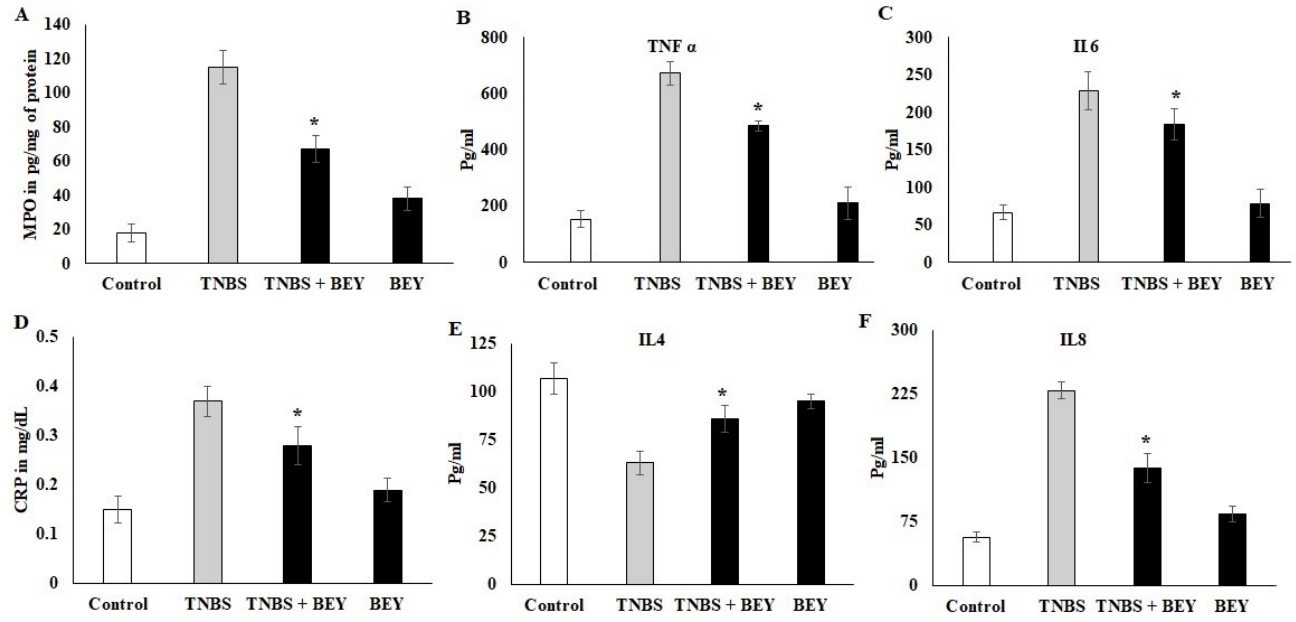
Figure 3. Effect of BEY on inflammatory markers in TNBS-induced colitis mice. The myeloperoxidase-infiltration marker was quantified in TNBS-induced colitis mice and BEY-treated mice after 14 days of the experiment. The values are expressed in pg/mg protein. ( A ) the neutrophil infiltration marker MPO was quantified; ( B , C ) TNF- α and IL-6 (pro-inflammatory markers) were quantified in TNBS-induced colitis mice and BEY-treated mice after 14 days of the experiment. The values are expressed in pg/mL. ( D ) The lymphocytes degradation marker (C-reactive protein) was quantified in TNBS-induced colitis mice and BEY-treated mice after 14 days of the experiment. The values are expressed in mg/dL. ( E , F ) IL4 and IL8 (anti-inflammatory and macrophage markers, respectively) were quantified in TNBS-induced colitis mice and BEY-treated mice after 14 days of the experiment. The values are expressed in pg/mL. All data were collected from three individual experiments and pooled and expressed as mean ± SD ( p < 0.05). * p < 0.05 represents significance compared to the TNBS vs. TNBS + BEY group.